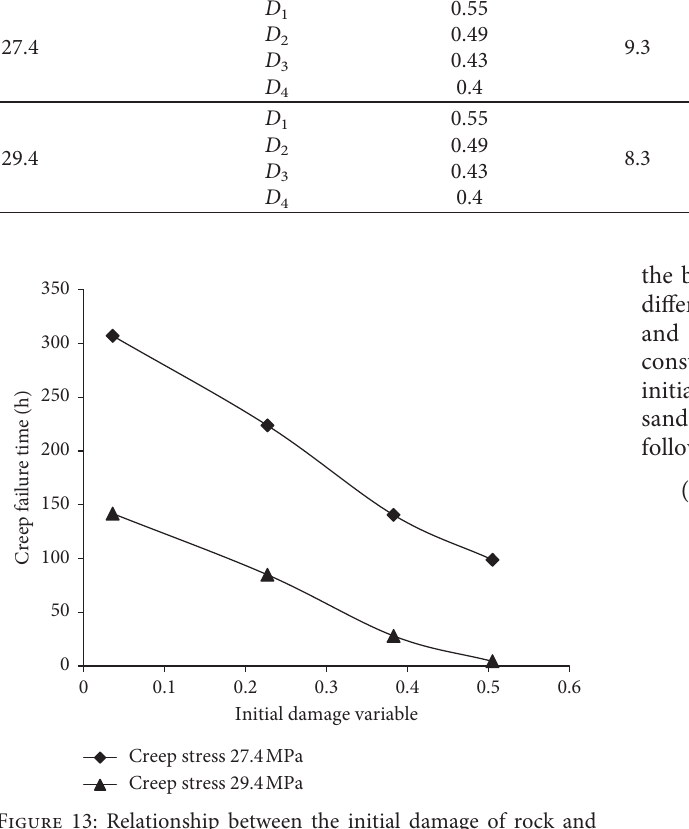
Table 9: Model parameters and creep failure time of rock specimens with different initial damage at the creep stress level 27.4 and 29.4MPa. Creep stress (MPa)